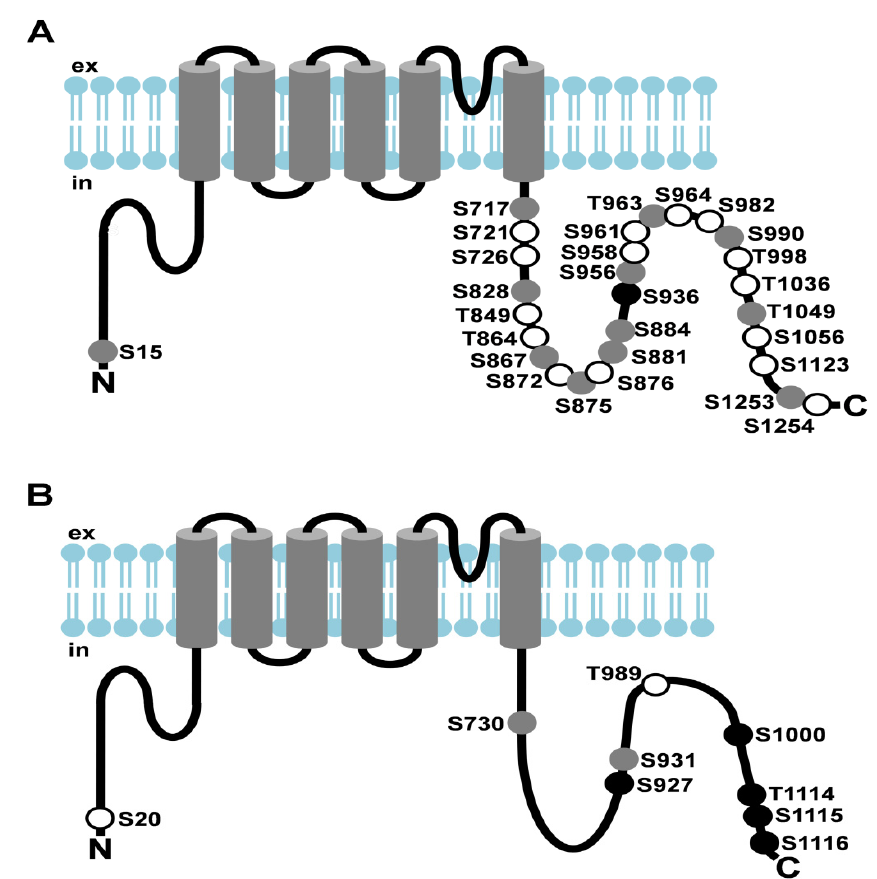
Figure 2. Light-dependent phosphorylation of Drosophila TRP and TRPL channels. ( A ) Cartoon depicting Drosophila TRP and its light-dependent phosphorylation sites; ( B ) Cartoon depicting Drosophila TRPL and its light-dependent phosphorylation sites. Amino acid residues that undergo phosphorylation are shown as circles. Sites that exhibited enhanced phosphorylation in the light are shown as white circles, sites that exhibited enhanced phosphorylation in the dark are shown as black circles, sites that revealed no significant difference in phosphorylation between light- or dark-adapted flies or that could not be assessed quantitatively are shown as grey circles; ex, extracellular; in,